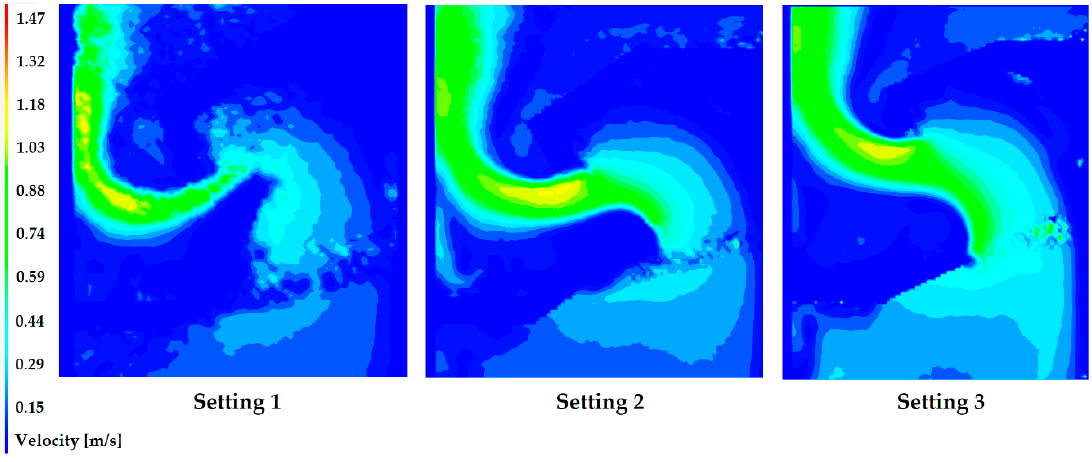
Figure 6. The velocity distribution based on the PIV from the first measurement area [22].